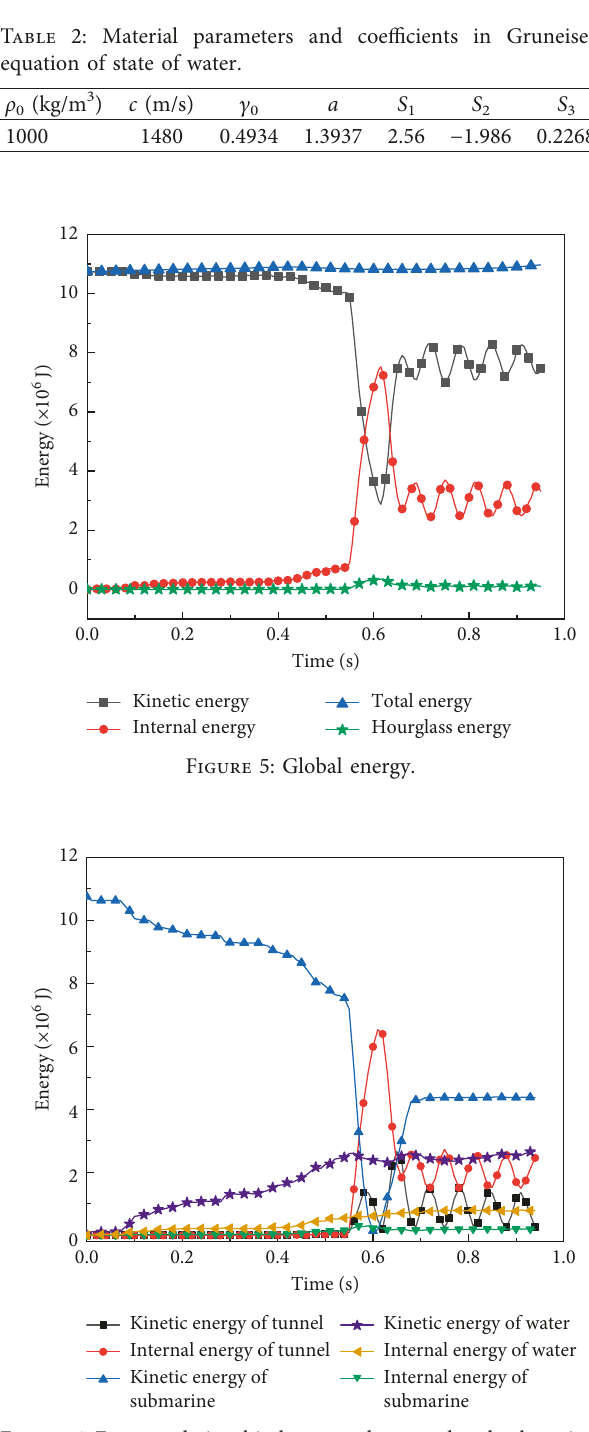
Figure 6: Energy relationship between the tunnel and submarine.